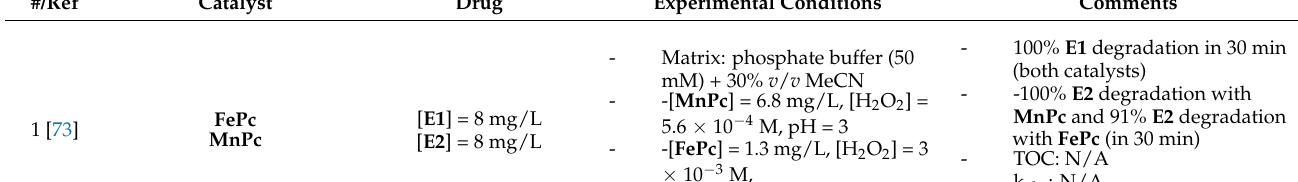
Table 7. Summary of miscellaneous pharmaceuticals’ degradation processes using TPM-based catalysts. #/Ref Catalyst Drug Experimental Conditions